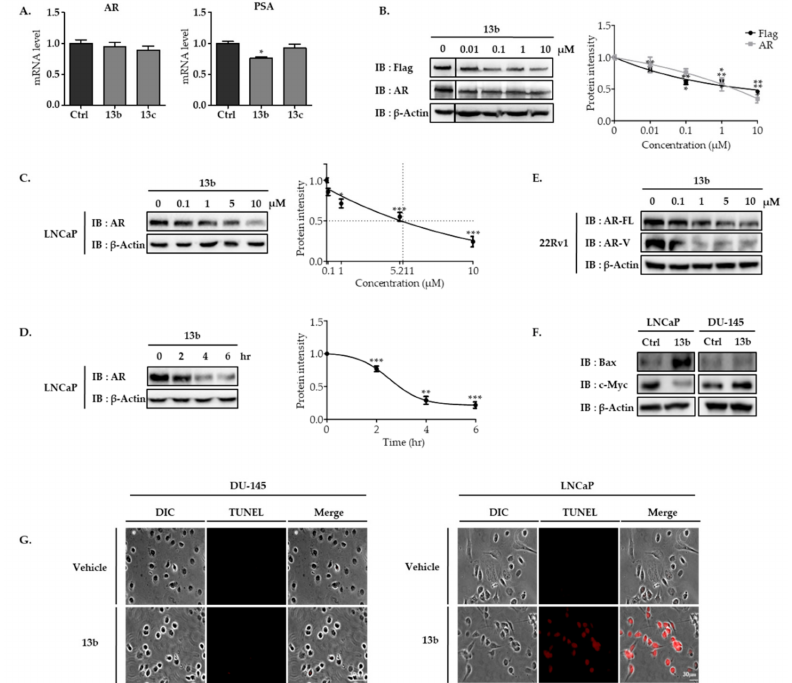
Figure 4. Effects of the novel AR PROTACs. ( A ) mRNA levels of AR and PSA in LNCaP cells treated with AR PROTACs (10 µ M) (n = 3). ( B ) Degradation of ectopically expressed AR in HEK293T cells treated with different concentrations of 13b for 24 h and the quantitative analysis by densitometry. ( C ) Dose-dependent degradation of endogenous AR protein in LNCaP cells treated with 13b for 24 h. DC 50 : 5.211 µ M. ( D ) Time-kinetics of 13b -mediated degradation of AR in LNCaP cells treated with 13b (10 µ M). All protein intensity analyses were performed in triplicate. ( E ) Effect of 13b on the protein levels of AR and AR variant (AR-V). 22Rv1 cells were treated with increasing amounts of 13b for 24 h and the protein levels were analyzed by immunoblotting. ( F , G ) AR transcriptional activity-dependent proapoptotic effects of 13b on prostate cancer cells. LNCaP and DU-145 cells were treated with 13b for 24 h and subjected to immunoblotting to determine the levels of Bax and c-Myc ( F ). Analysis of apoptosis by TUNEL staining. LNCaP and DU-145 cells were treated with 13b (5 µ M) for 24 h and subjected to TUNEL staining ( G ). The data represent mean values ± SEM. *** p < 0.001, ** p < 0.01, * p <